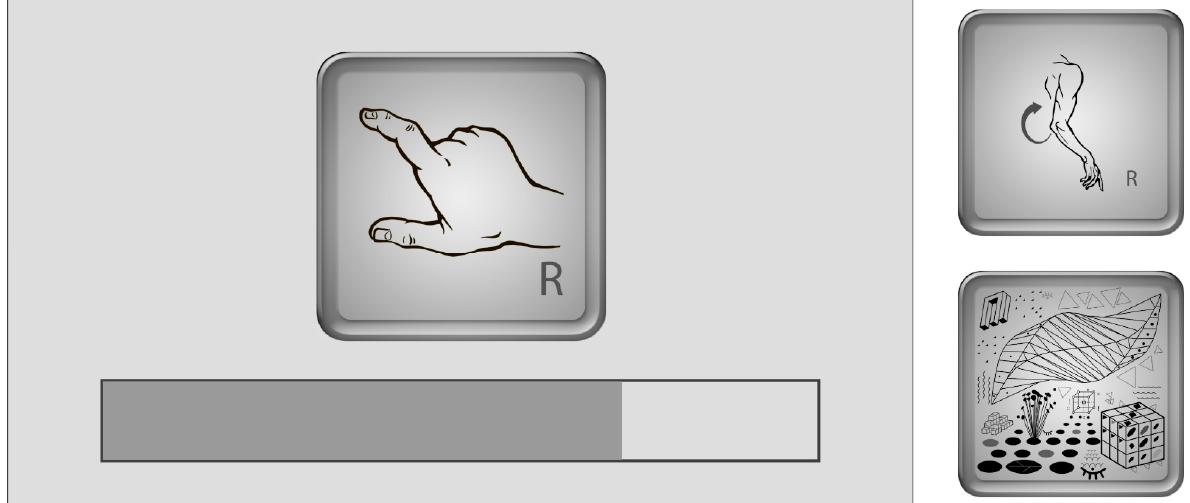
Figure 1. ( left ) Stimulus presentation display with the feedback progress bar. The correct classification of the target mental state (in this case–FR) caused the “progress bar” animation to play. ( right ) Pictures used for cueing shoulder imagery (SR) and the visual attention task.